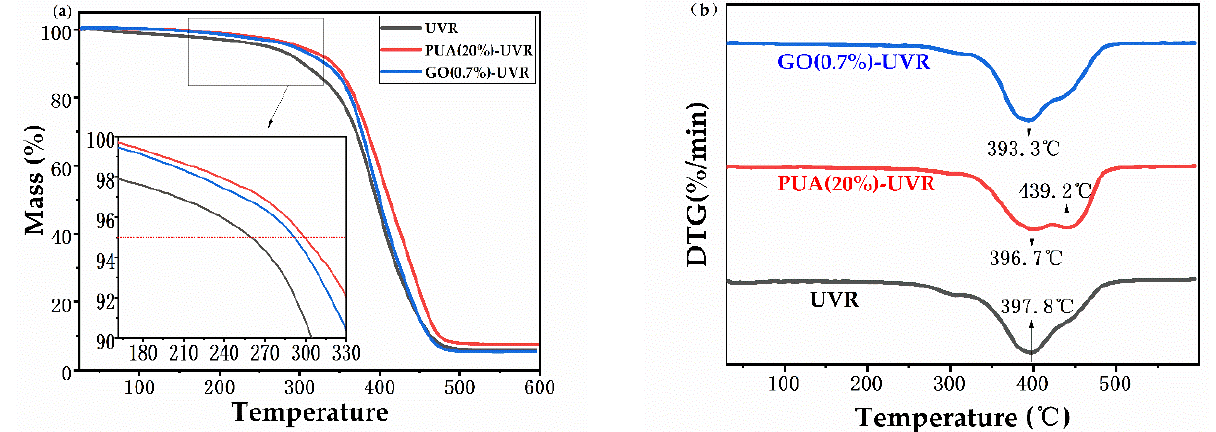
Figure 4. ( a ) Thermogravimetric (TG) and ( b ) Derivative Thermogravimetric (DTG) curves of free − radical/cationic hybrid photosensitive resin solidified product with polyurethane acrylates (20%) and graphene oxide (0.7%) modified photosensitive resins.